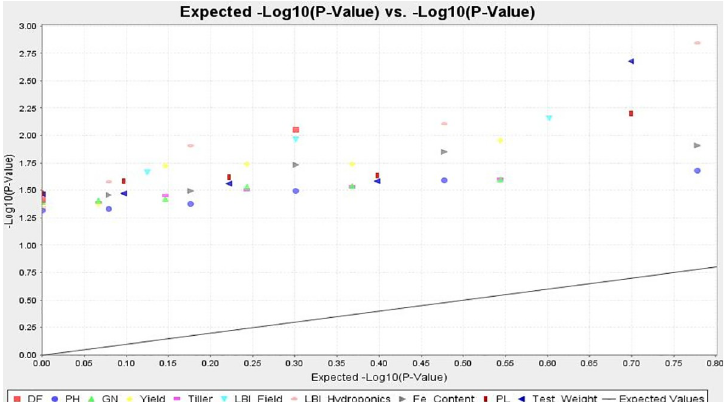
Fig 7. Quantile-quantile plot showing the significantly associated molecular markers with different traits by adopting MLM approach.